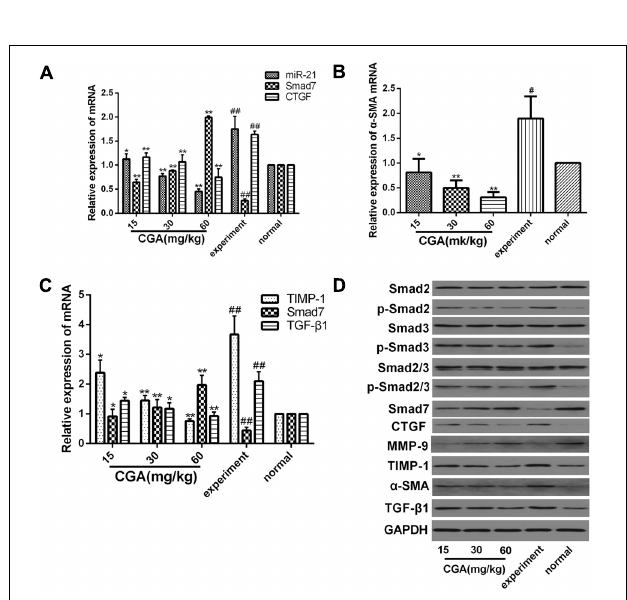
FIGURE 10 | Effect of CGA on the TGF- β 1/miR-21/Smad7 signaling pathway in CCl4-induced rats. (A–C) The mRNA levels were measured by real-time quantitative PCR. (D) The protein levels were assayed by western blotting. The data from three independent experiments are expressed as the means ± SD. ∗ P < 0.05 compared with the experimental group; ∗∗ P < 0.01 compared with experimental group; # P < 0.05 compared with the normal group; ## P < 0.01 compared with the normal